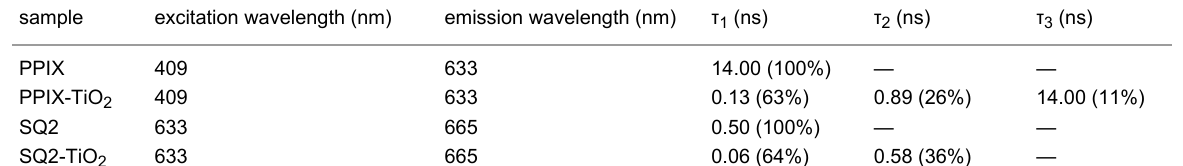
Table 2: Dynamics of picosecond-resolved fluorescence transients of the dyes PPIX, SQ2 and the nanohybrids. sample